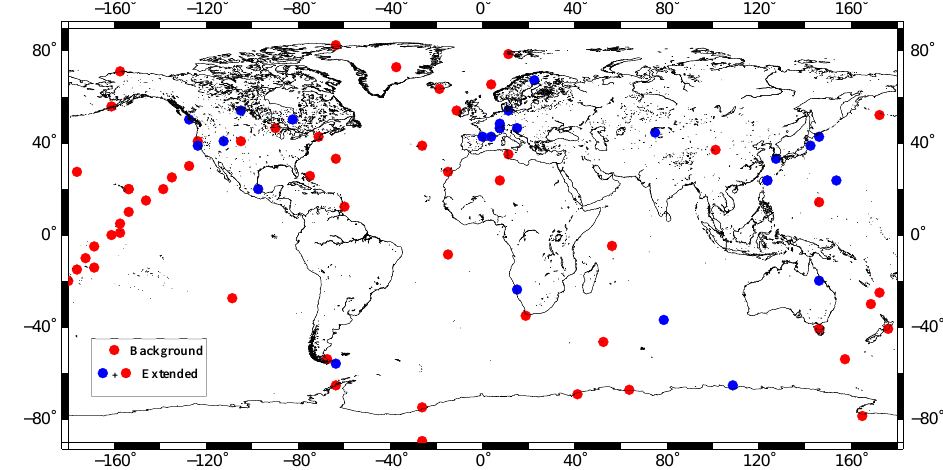
Figure 1. Location of the surface stations in the “background” (red circles only) and “extended” network (blue and red circles).